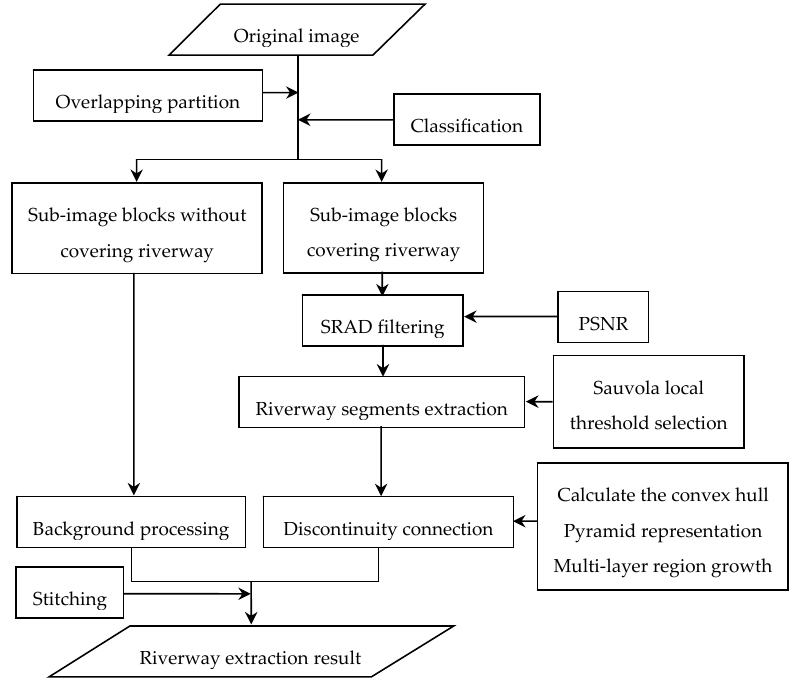
Figure 1. Framework of urban riverway extraction method.